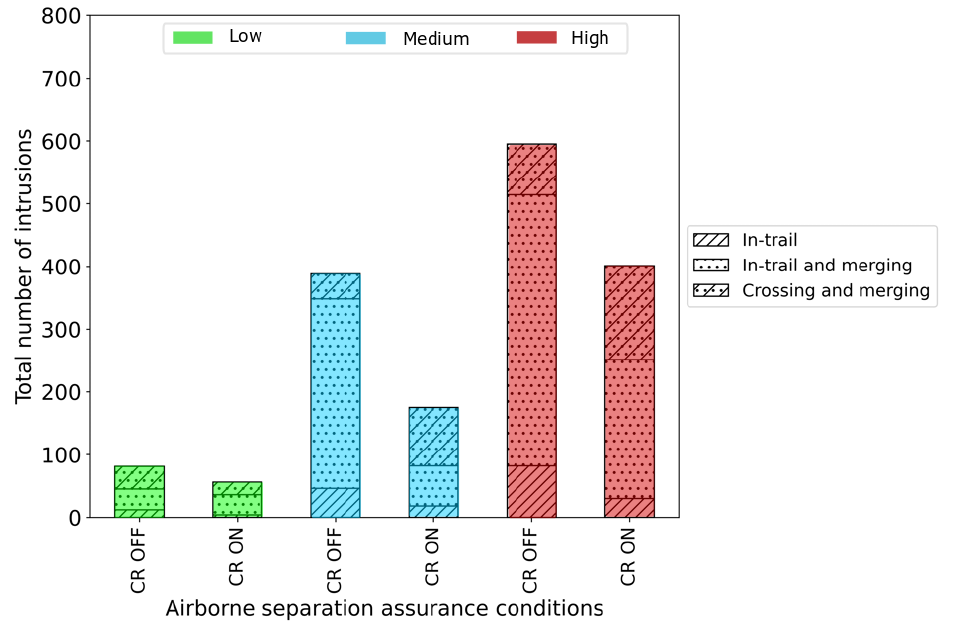
Figure 5. The total number of pairwise intrusions and their associated type with (CR ON) and without (CR OFF) tactical conflict resolution for low, medium and high traffic